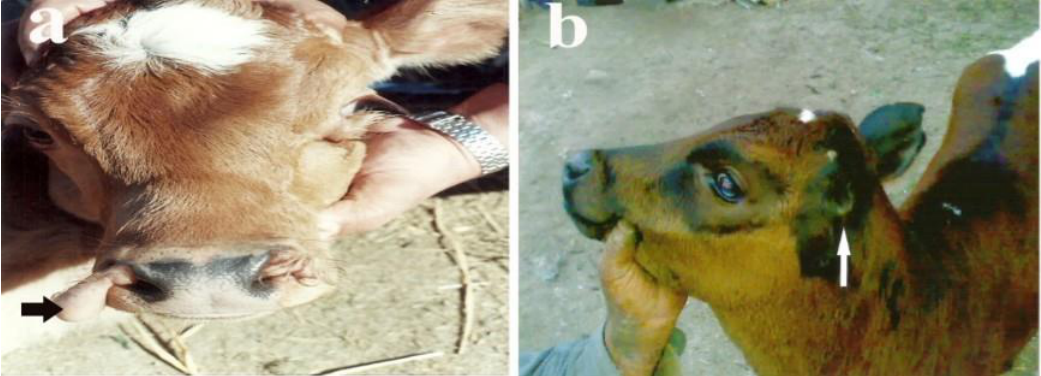
Fig. 3: Gross pictures showing congenital nasal dermoid cyst (arrow) (a) and anotia (arrow) (b) in two mixed breed